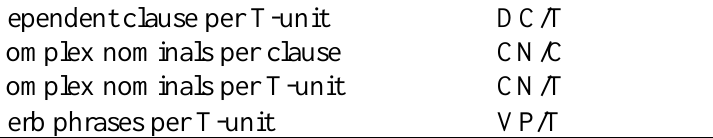
Sample Coding of Idea Units and Discourse